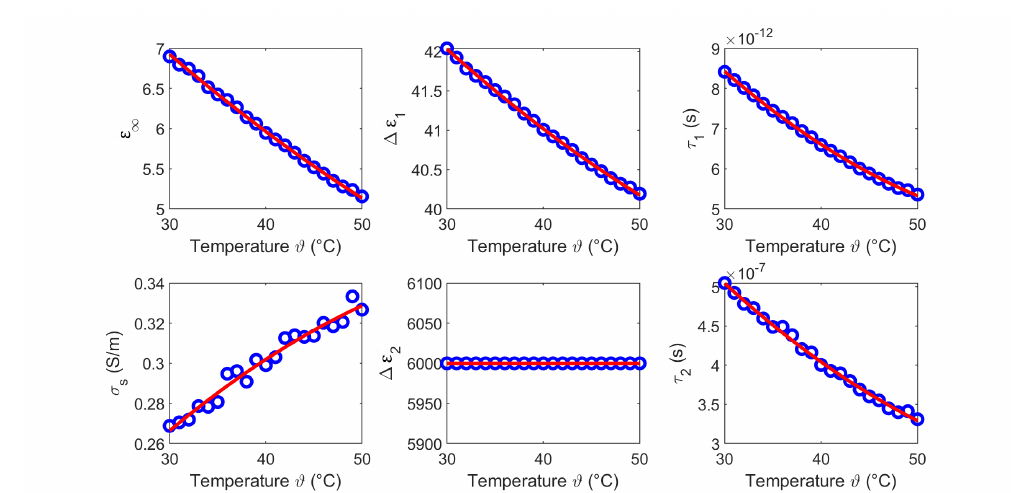
Figure 7. Temperature dependent Cole-Cole parameters (blue circles) of liver and the corresponding second order polynomial fit (red curves).